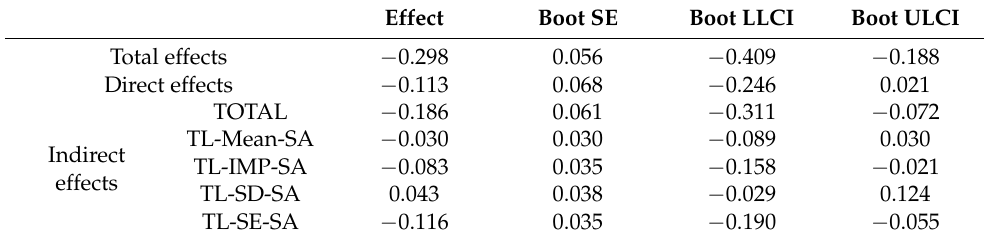
Table 5. Total, direct, and indirect effects of TL on surface acting.